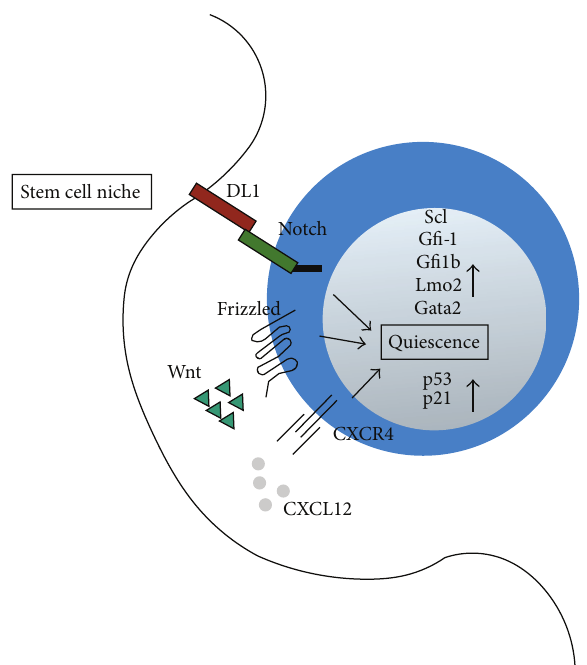
Figure 1: Hematopoietic stem cells maintain quiescence through extrinsic and intrinsic signals. The stem cell niche provides signals that regulate HSC quiescence and localization in the niche. DL1 and Notch; CXCL12 and CXCR4; and Wnt and Frizzled. HSC intrinsic transcription factors regulate signaling process to keep HSC in a quiescent